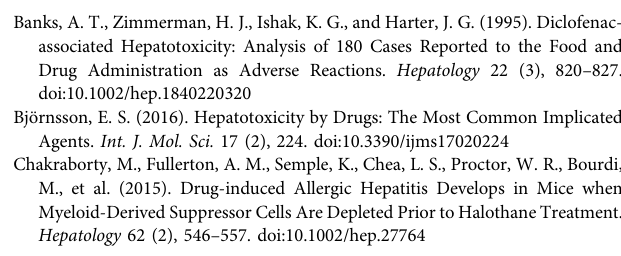
Supplementary Figure S1 | Pro fi le of hepatotoxicity-related metabolomic biomarkers of Dicl-IDILI. (A) The radar plot of 17 hepatotoxicity-related metabolites showing evidence of the different metabolic pro fi les between the Mod and Mod/Dicl groups. (B) Schematic diagram of the disturbed metabolic pathways. (C) Network map of metabolic pathways and metabolites. Supplementary Figure S2 | Hepatotoxicity-related metabolite biomarkers of Dicl- IDILI. (A) Cluster analysis on the AUC and p-values from the ROCs of each of 17 metabolites in discriminating the Dicl-IDILI (Mod/Dicl) group from the susceptibility model (Mod) group. The color indicates the AUC value. ADHUA: 2-Amino-3,7- dideoxy-D-threo-hept-6-ulosonic acid; LysoPE: LysoPE [0:0/20:4(5Z,8Z,11Z,14Z)]. (B) Differential expressions of 4 metabolites in the Mod/Dicl and Mod groups (*p